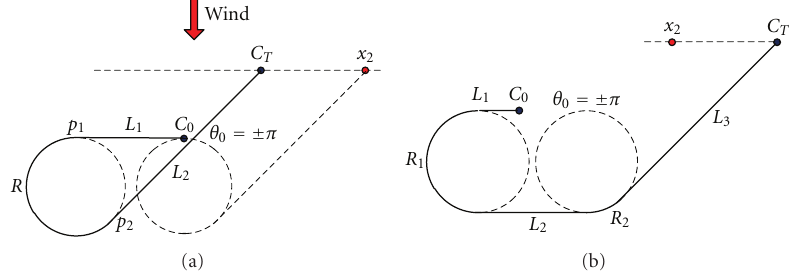
Figure 13: Wearing path between two points when θ 0 = ± π and y T ≥ y 0 , with x 2 = x 0 + ( y T − y 0 ) / tan θ T + r/ tan( θ T / 2). (a) For x T < x 2 and (b) for x T ≥ x 2